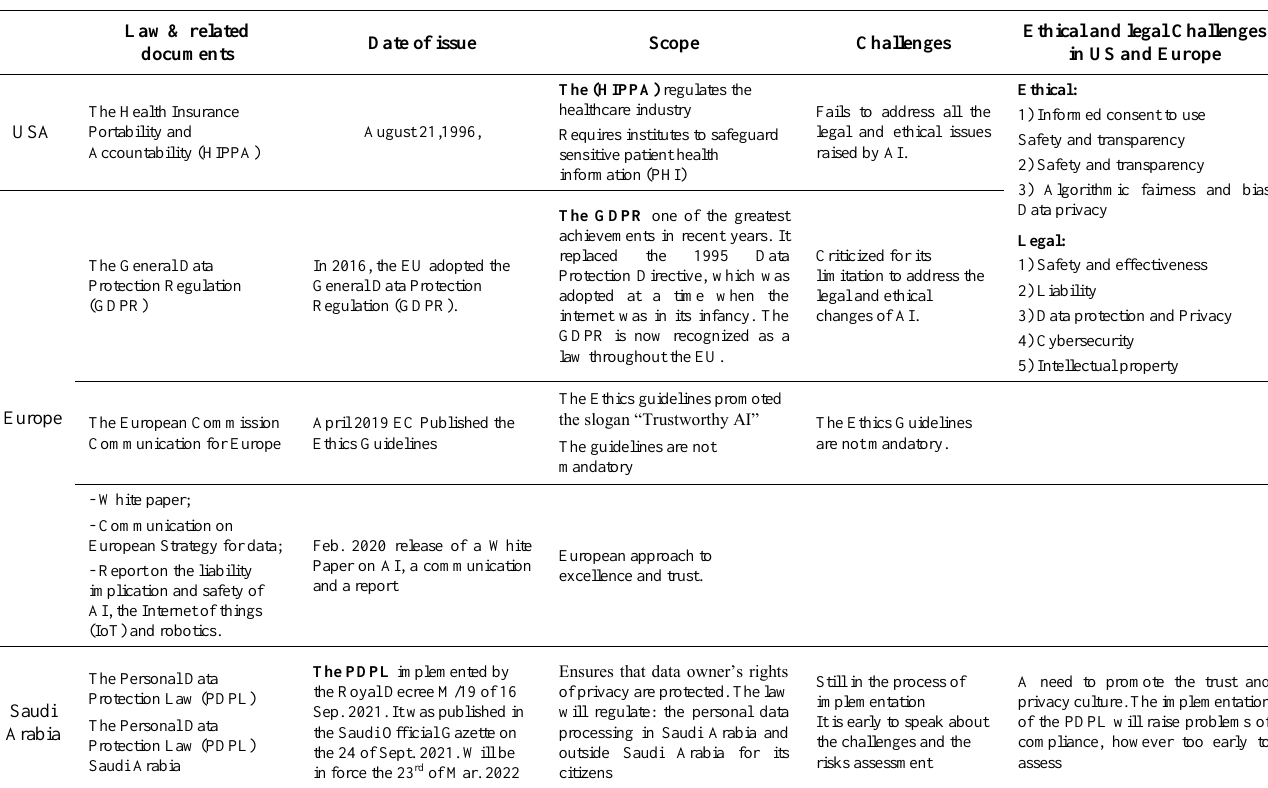
Table 1. AI usage in healthcare in the different